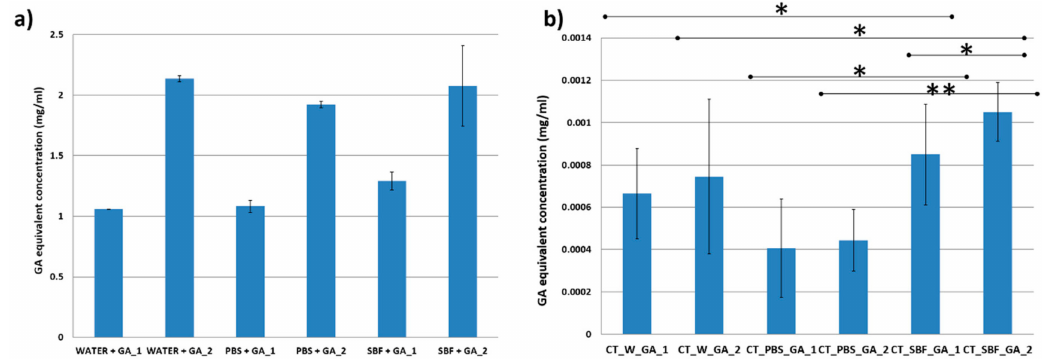
Figure 1. Results of the Folin–Ciocalteu test for quantification of gallic acid in ( a ) source solutions and on ( b ) functionalized samples (* p < 0.05, ** p < 0.5).